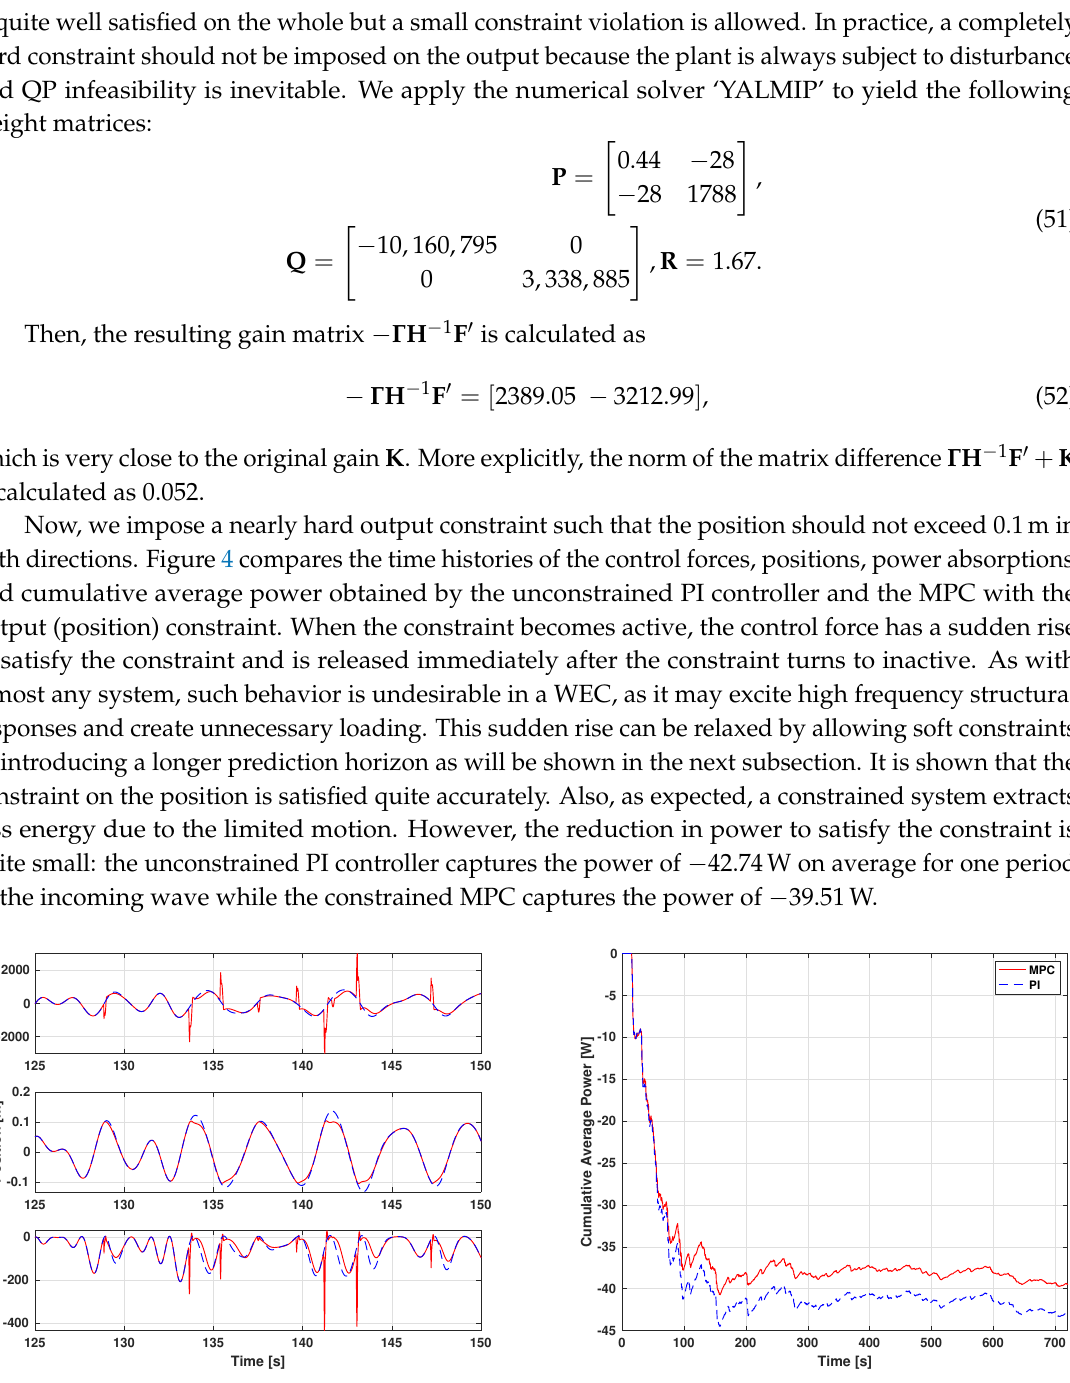
Figure 4. Comparison of the control forces, positions, power absorptions, and cumulative average power obtained by the PI controller and the MPC (scenario